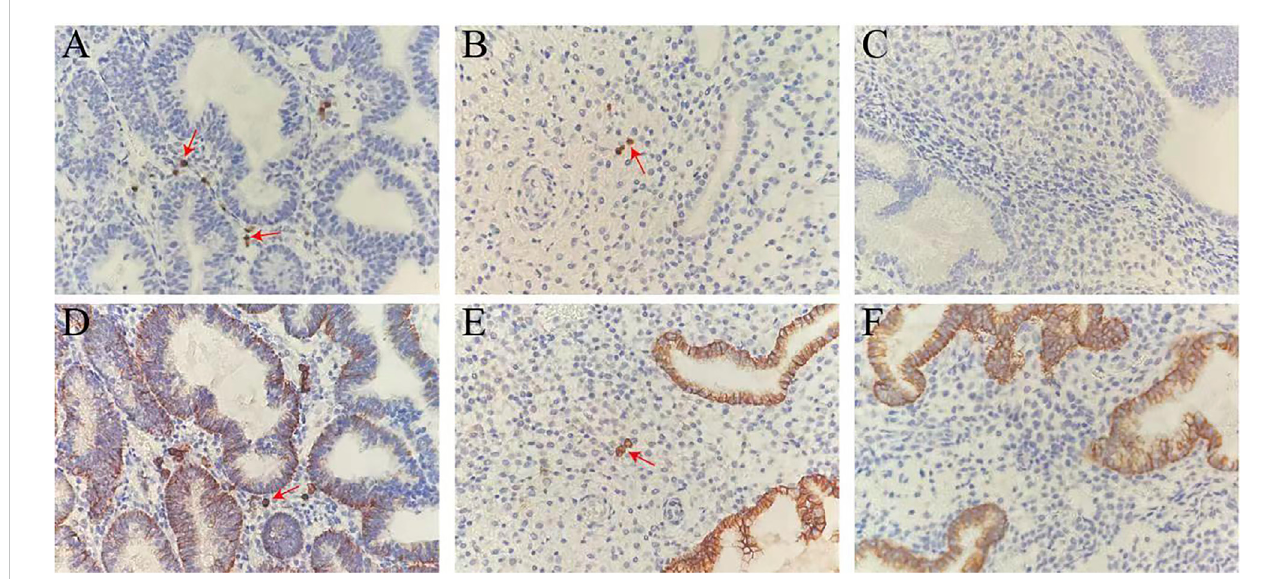
FIGURE 2 Mum-1 + /CD138 + immunohistochemical staining in the endometrium. (A – C) Mum-1 + immunohistochemical staining in the strong positive, weak positive and negative groups. (D – F) CD138 + immunohistochemical staining in the strong positive, weak positive and negative groups. The plasma cells in stroma were positively stained with anti-Mum-1/CD138 (red arrows). Magni fi cation